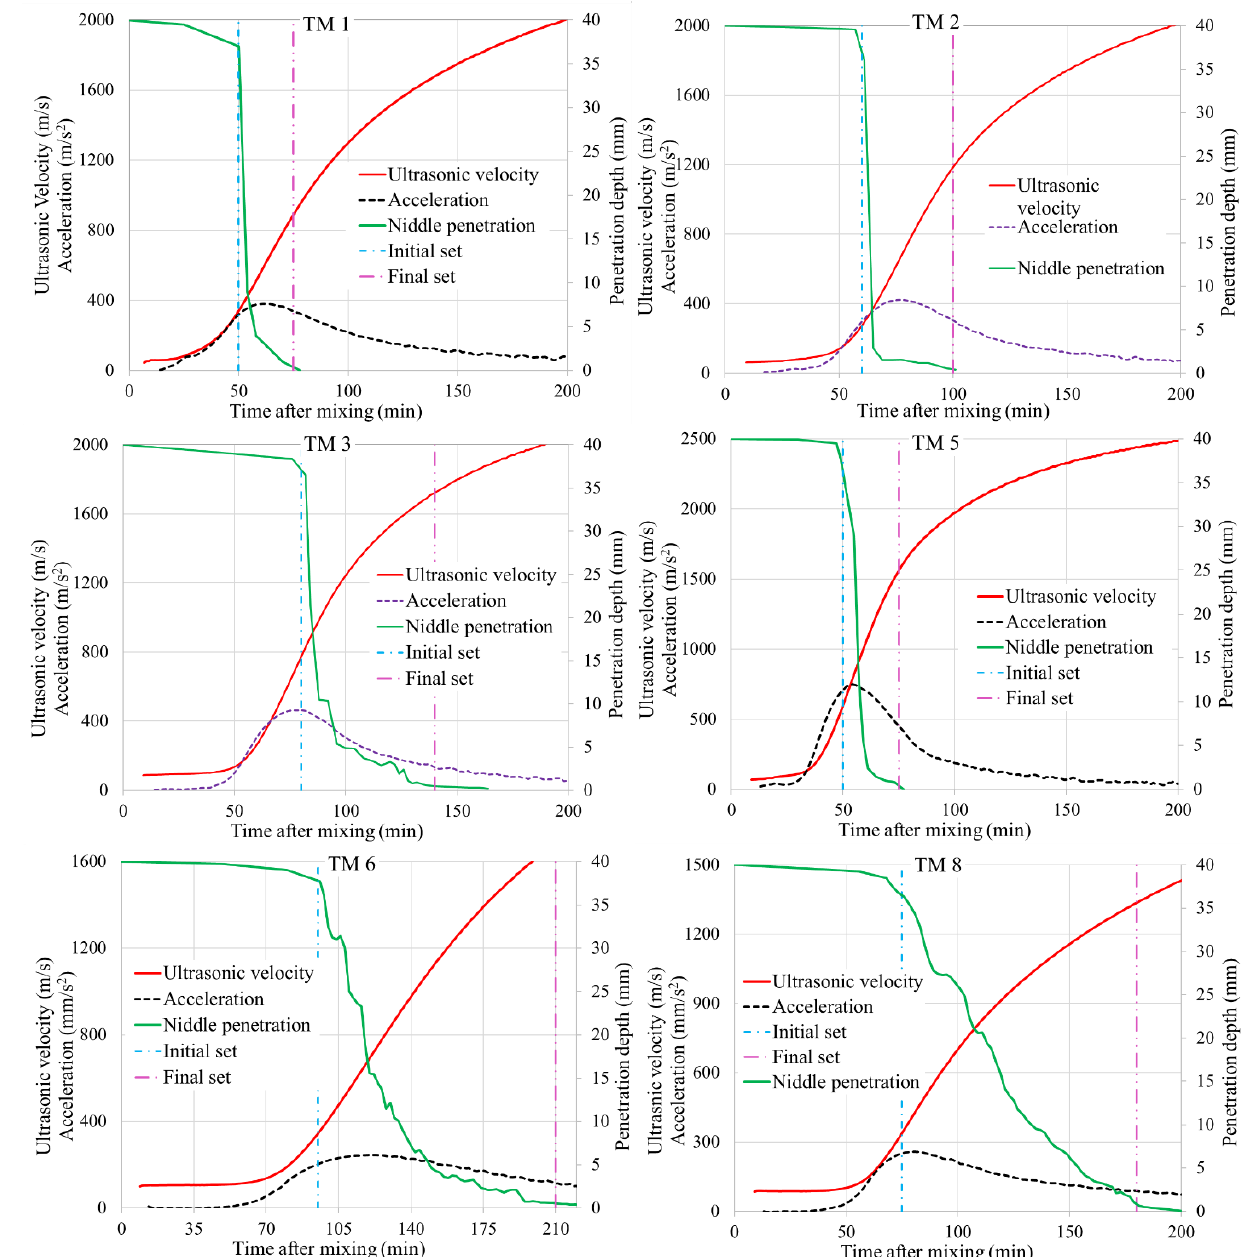
Figure 4. Correction of the ultrasonic curve with penetration depth.